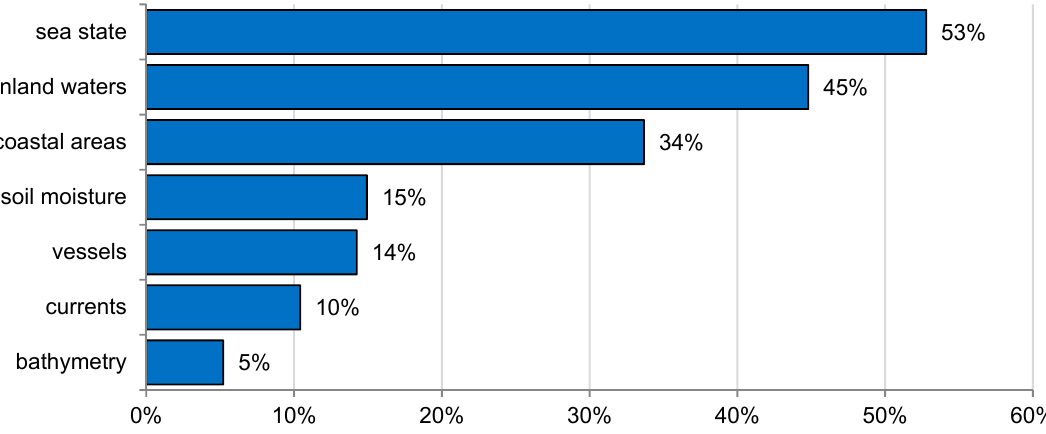
Figure 8. Thematic fields of hydrosphere-related TerraSAR-X proposals, sorted by frequency addressing oceanographic applications, coastal zones, inland waters, soil moisture and the identifications and observation of ships and ship traffic.